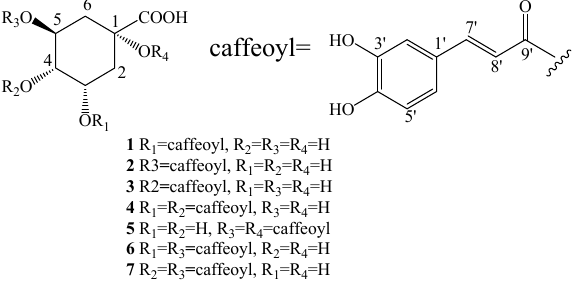
Figure 2. The chemical structures of the compounds 1 – 7 isolated from Ch. coronarium L .